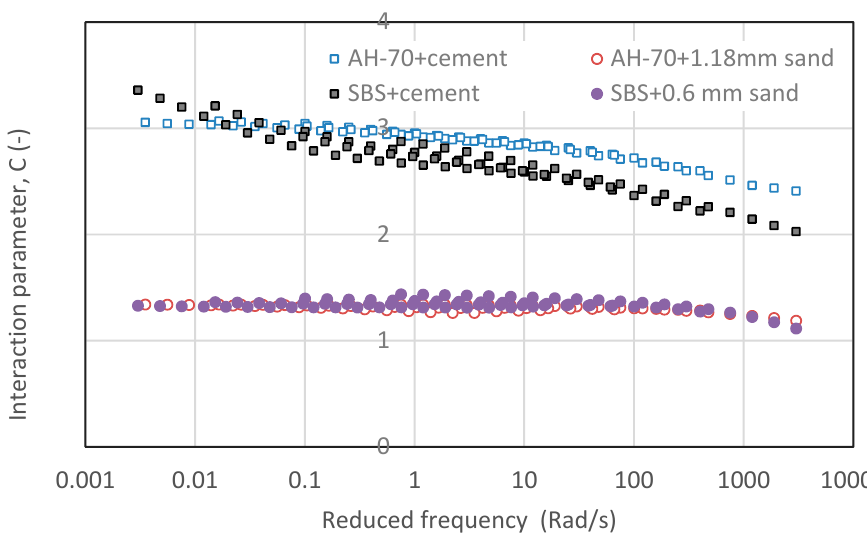
Figure 18. Interaction parameters, C values of mastic made by using cement as filler and mortar using river sand as a substitution for fine aggregate. Table 7. Interaction validation by using cement as filler and river sand as a substitution for fine aggregate. Interaction Parameter, Material Scale Bitumen Filler Fine Aggregate C Value AH ‐ 70 Cement(1:1) ‐ 2.864 Mastic SBS Cement(1:1) 2.678 AH ‐ 70 Limestone Mortar 1.340